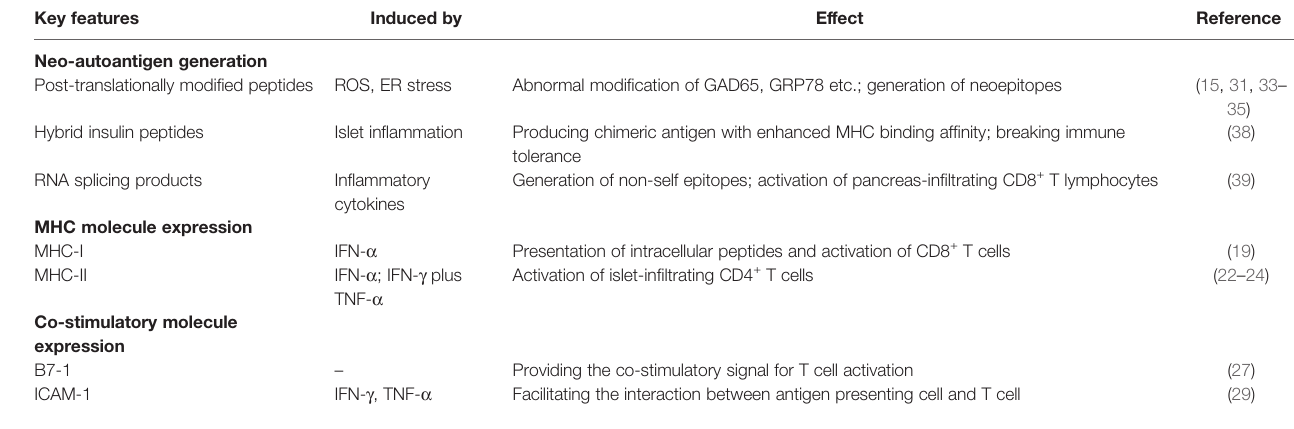
TABLE 1 | Key features of APC-like islet b